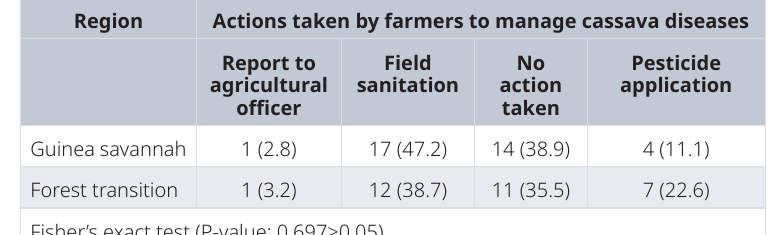
Table 12. Fisher’s exact test for cassava disease management practices by agro-ecology. Region